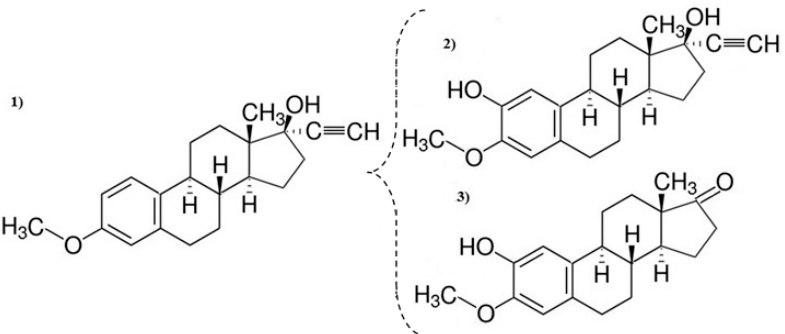
Figure 15. Identified 1 mestranol by-products, where 2 is 2,6-di-tert-butylhydroquinone and 3 is 2-hydroxy-3-methoxy-estrone.